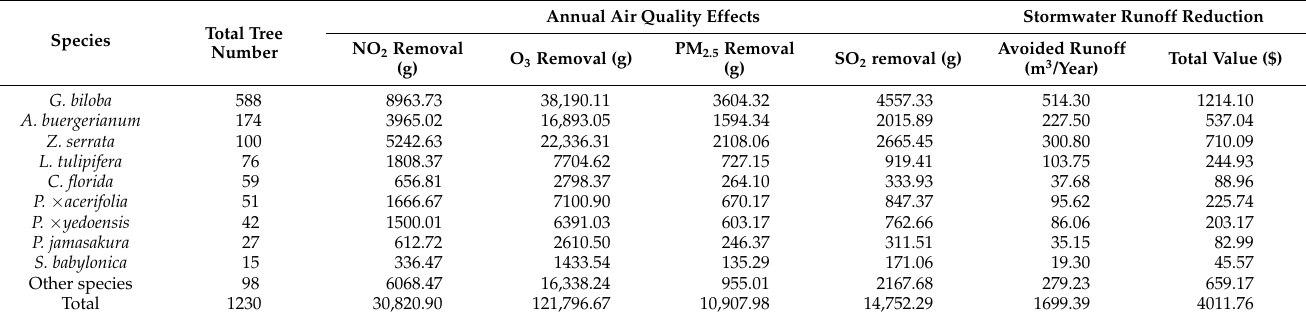
Table 3. Annual air quality and avoided rainwater runoff benefits from sample street trees in Kyoto City. Species